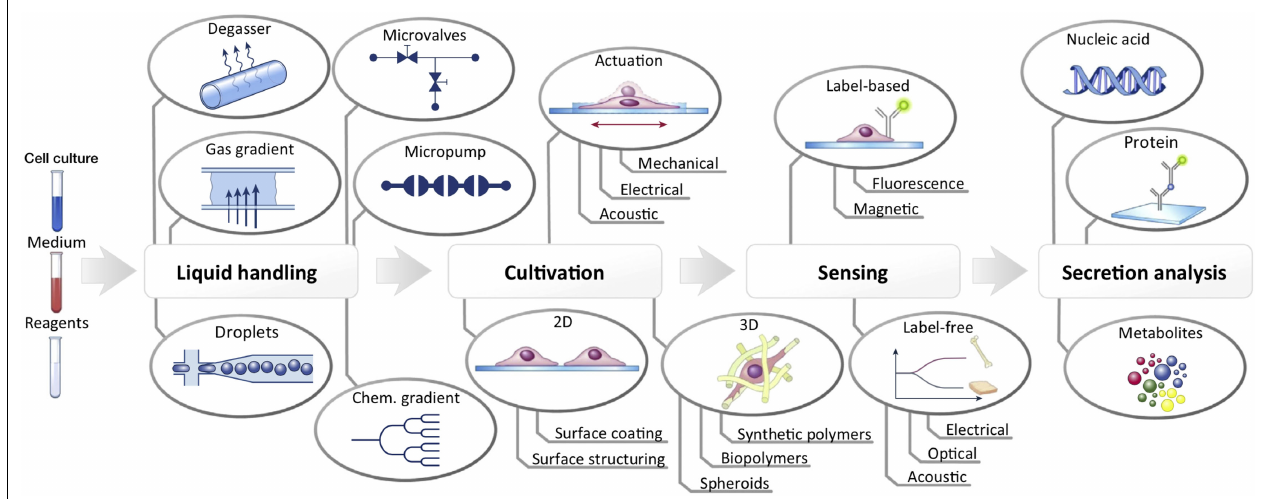
FIGURE 6 | Schematic illustration of components and systems available to date that can be integrated into a fully automated lab-on-a-chip for cell culture analysis . Reproduced from Ertl et al. (2014) by permission of by